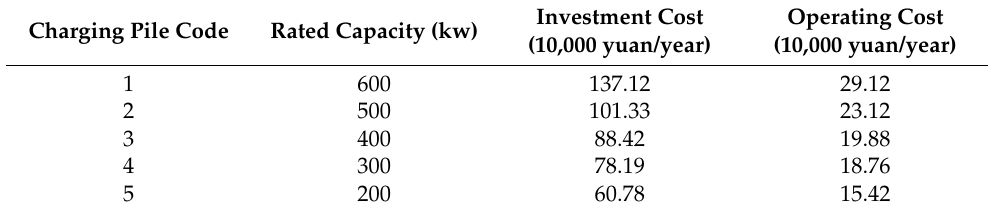
Table 3. The installation position, rated capacity, and cost of charging piles obtained from the model. Charging Pile